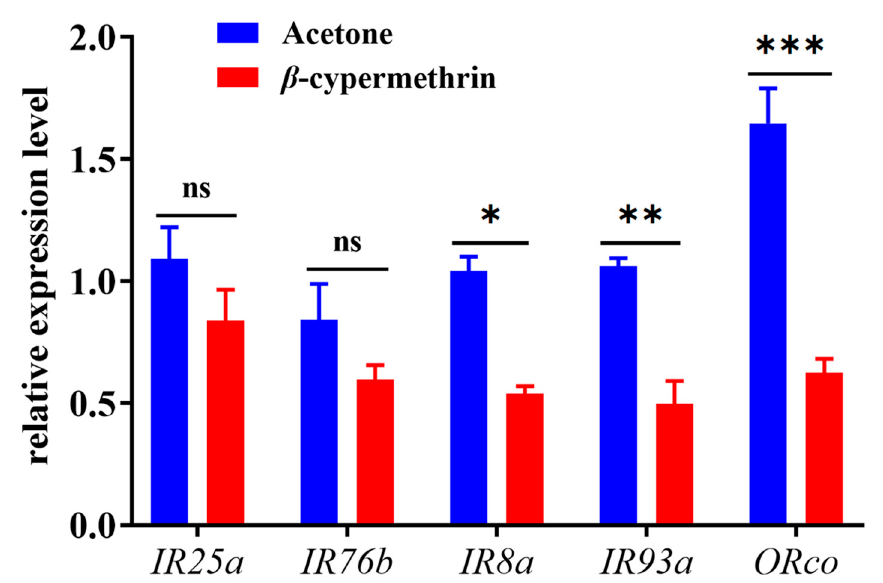
Figure 3. Transcriptional expression profiles of ORco and IRcos after β -cypermethrin induction (LD 30 = 10 ng/fly). Data were presented as mean ± SE, and asterisks represent a significant difference with analysis of Student’s t -test ( n = 4, * p < 0.05; ** p < 0.01; *** p < 0.001). No significant difference was represented by “ns”.